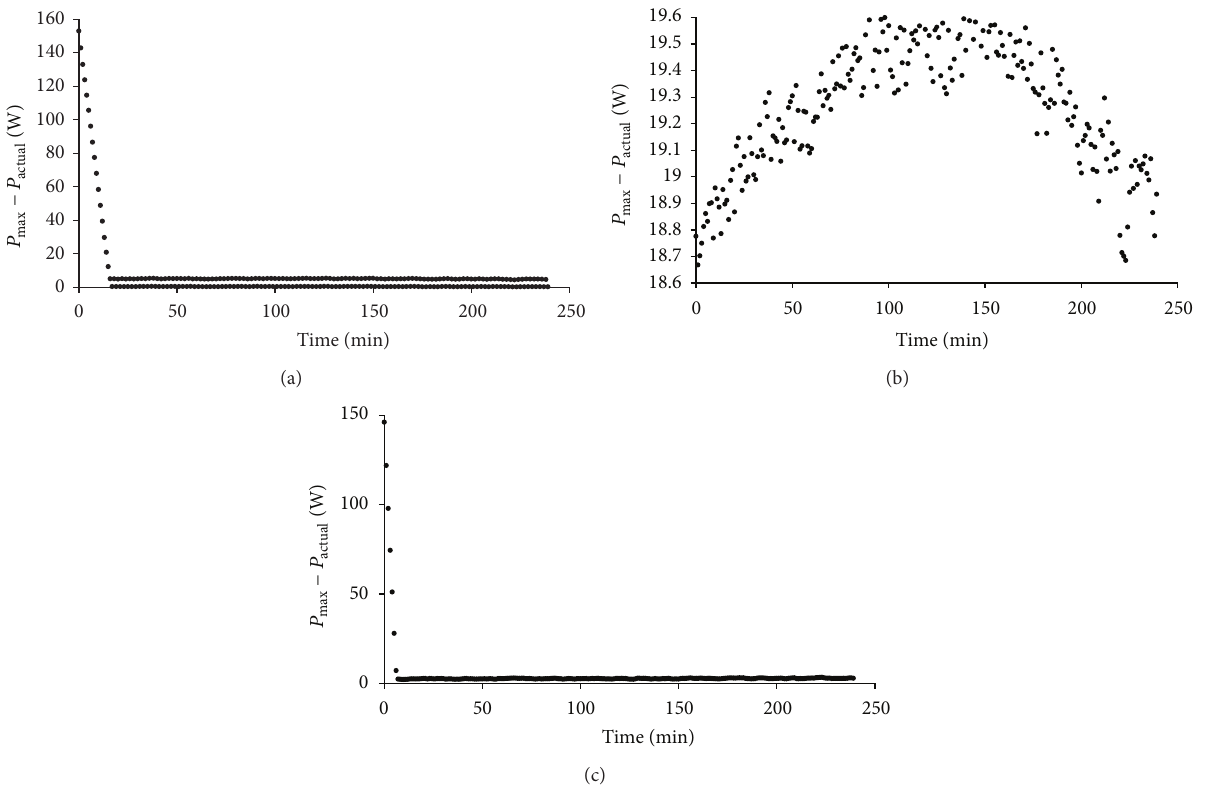
Figure 12: The maximum power point minus the predicted current power point corresponds to the same sensing time: (a) P&O method, (b) open-circuit voltage method, and (c) RLMPPT method.